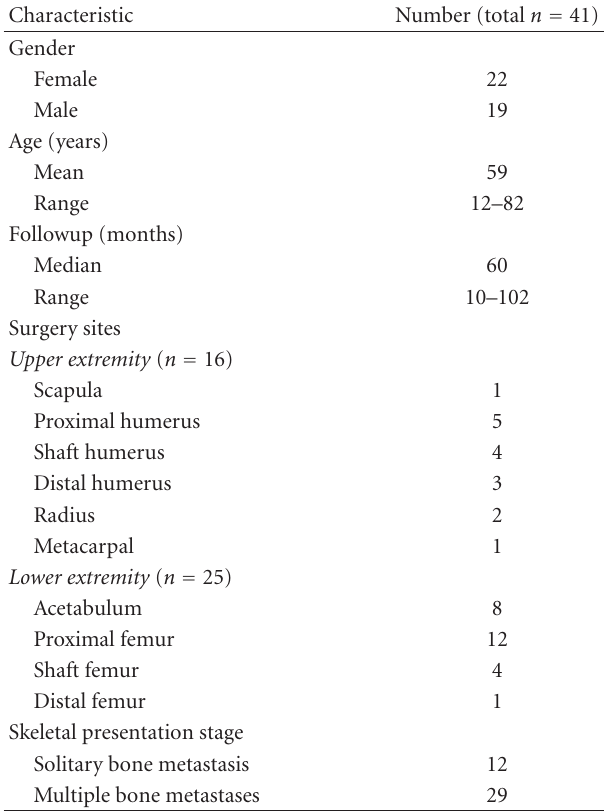
Table 1: Patient